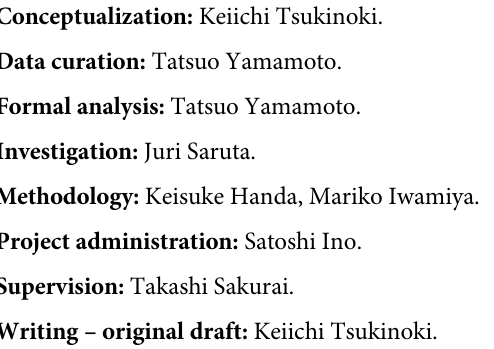
S1 Fig. Original gel. The slide shows the original gel image in Fig 2. Western blotting of (A) SDS-PAGE-separated components, (B) secretory protein, and (C) H chain; + indicates saliva purified with jacarin and–indicates unpurified saliva. Only saliva purified with jacarin is shown in Fig 2, which was cropped. No image processing was performed. M is a molecular weight marker. S2 Fig. Percentage of biding inhibition. CRsA-positive saliva showed the neutralization activ- ity for 21.72% (right bar). No apparent neutralization activity was observed in the CRsA-nega- tive saliva (left